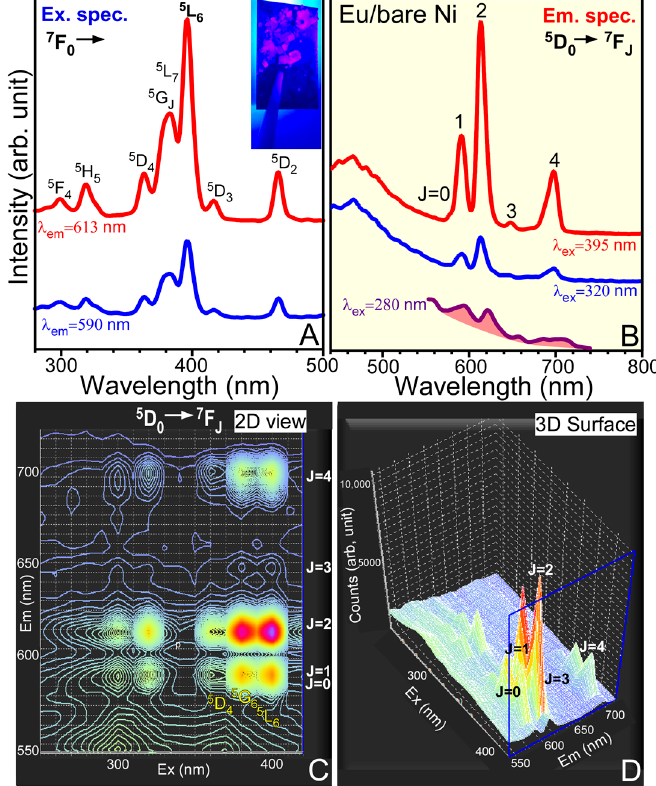
Figure 7. Excitation ( A ) and emission ( B ) spectra for a thick electrodeposited Eu on a Ni sheet, and the corresponding 2D- and 3D-PL contour mapping images ( C , D ).